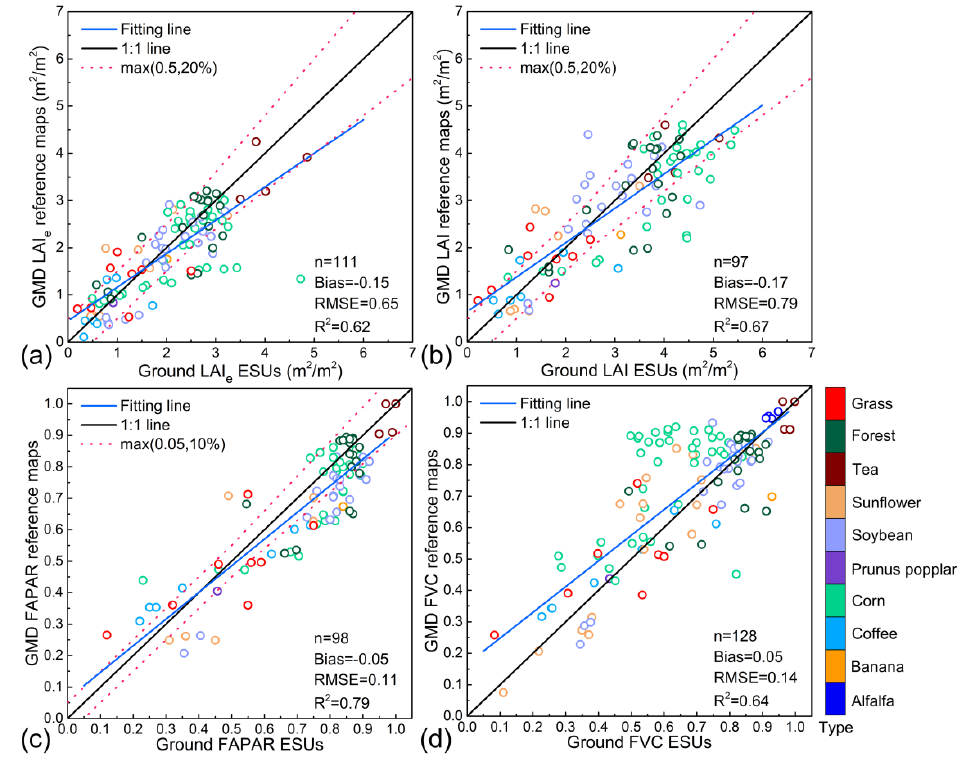
Figure A2. The comparison between ground ESUs and GMD reference maps. ( a ) Ground LAI e ESUs versus GMD LAI e reference maps; ( b ) Ground LAI ESUs versus GMD LAI reference maps; ( c ) Ground FAPAR ESUs versus GMD FAPAR reference maps; ( d ) Ground FVC ESUs versus GMD FVC reference maps. The colors stand for different vegetation types (i.e., crop types, forests, and grasses, respectively) shown in the right colorbar. The blue and black solid lines denote the fitting line and 1:1 line, respectively. The red dashed lines show the GCOS specifications boundaries for LAI e (max (0.5, 20%), LAI (max (0.5, 20%)) and FAPAR (max (0.05, 10%)).